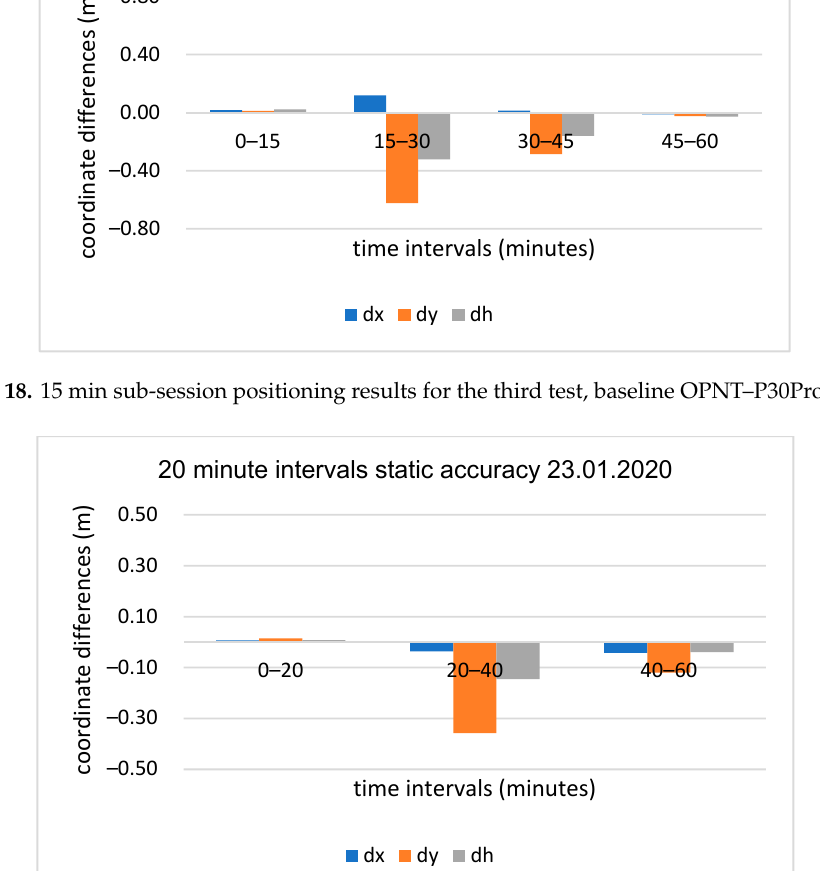
Figure 19. 20 min sub-session positioning results for the third test, baseline OPNT–P30Pro (4 km). Appl. Sci. 2020 , 10 , x FOR PEER REVIEW